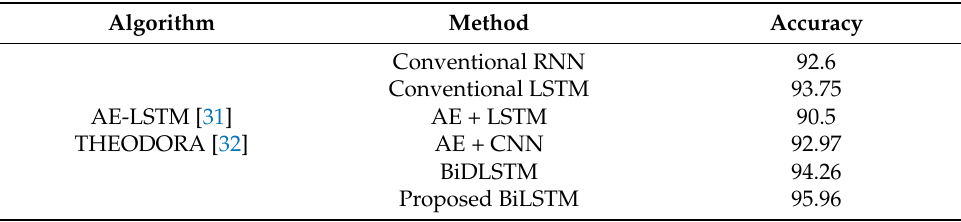
Table 2. Summary of the proposed model